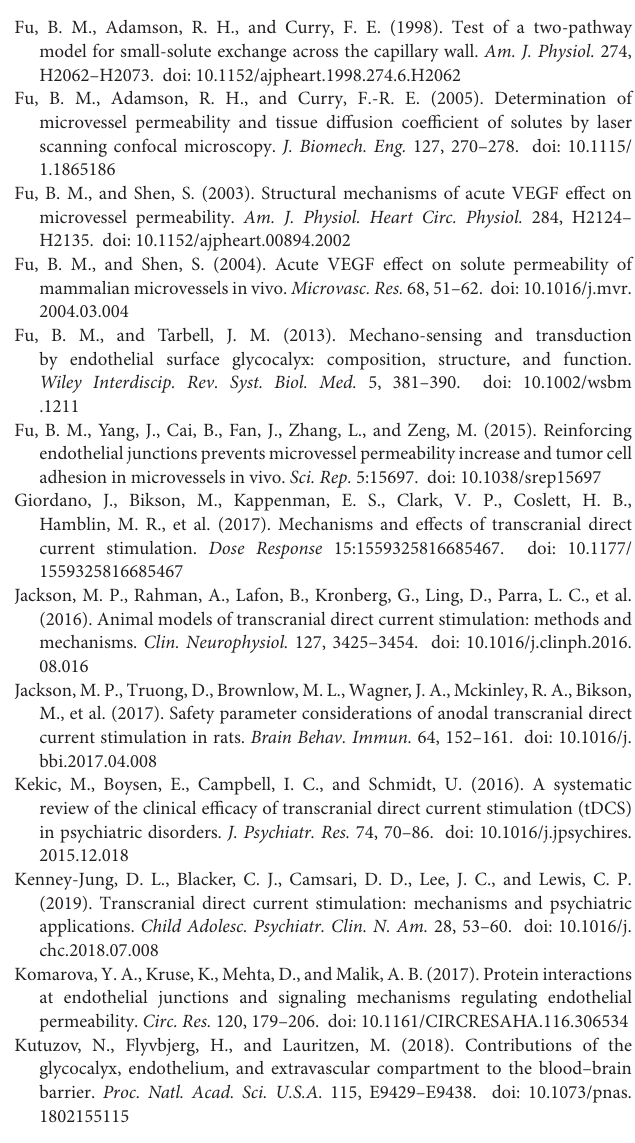
Supplementary Figure 1 | Comparison of in vitro BBB permeability to Dex-70k measured with and without fixation. The in vitro BBB was formed by hCMEC monolayer. Supplementary Figure 2 | Confocal images of ZO-1, claudin-5, occludin and VE-Cadherin at the in vitro BBB formed by hCMEC monolayer. Supplementary Figure 3 | Comparison of normalized in vitro BBB permeability to Dex-70k under control and 0, 10, 30 and 60 min post 10 min 1 mA/cm 2 DCS treatment. ∗ p < 0.05. The in vitro BBB was formed by hCMEC monolayer. Supplementary Figure 4 | Bright-field images of the bEnd3 monolayer before and after 10 min–1 mA/cm 2